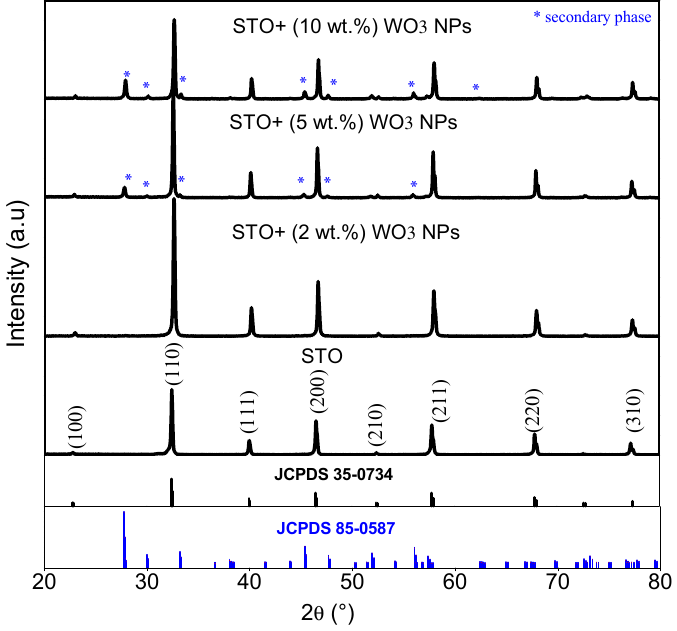
Figure 1. XRD patterns of STO ceramic and STO ceramics doped with x wt.% of WO 3 NPs. Table 1. Structural parameters deduced from XRD analysis.